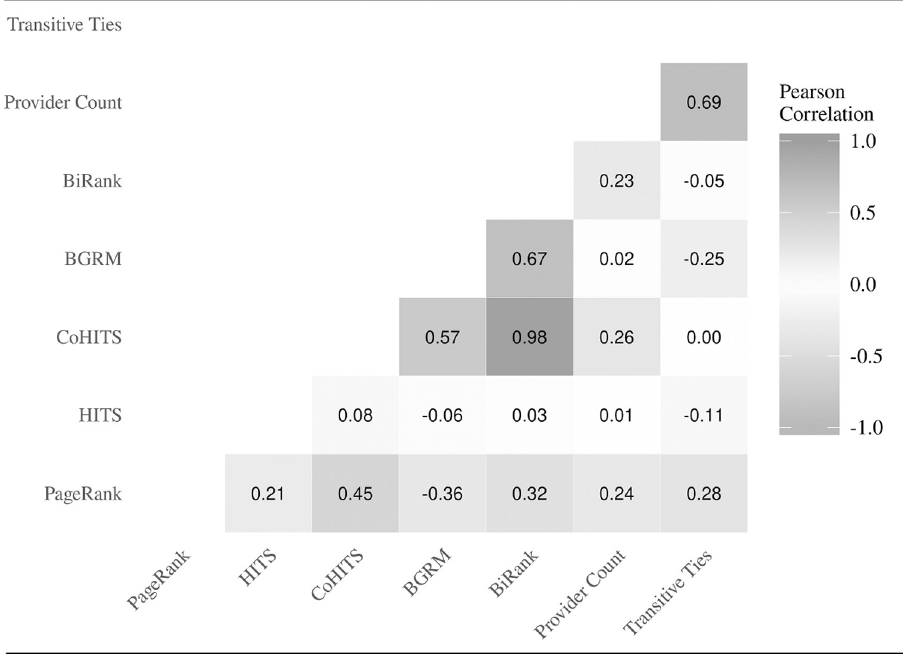
Fig 3. Correlation matrix of different centrality indices and key network parameters. The Pearson correlations are based on the full analytic sample (n = 1,920,554 patient-quarters). All variables are log-transformed. Spearman correlations yield qualitatively similar